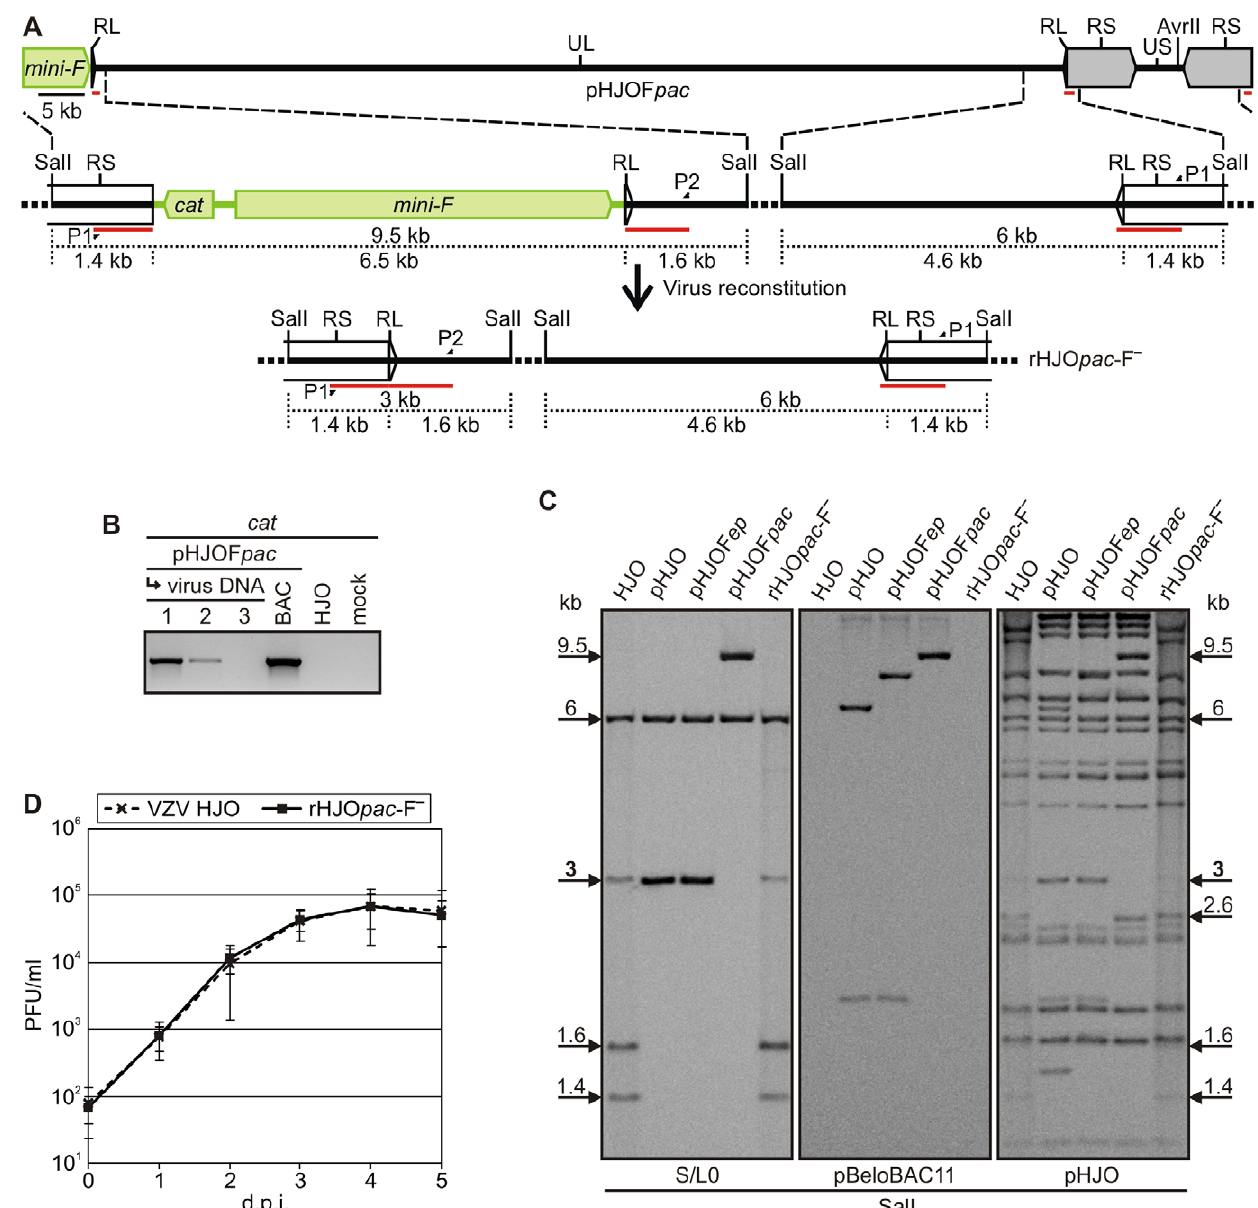
Figure 3. Mini-F sequence transposition into the genomic terminal junction and release upon virus reconstitution. A ) Detailed overview of the genomic transitions in pHJOF pac and rHJO pac -F - . The vector sequences (green) were released upon virus reconstitution from pHJOF pac and vector-free progeny rHJO pac -F - was generated. Lengths of both transitional SalI fragments and the distances from the SalI restriction sites to the genomic junctions are given (black dotted lines). Also, the binding sites of the Southern-blot probe (red bars) for analyzing the terminal junction and of the primers P1 and P2 (Table S1) used to generate the probe are indicated. B ) PCR analysis of the mini-F sequence release upon virus reconstitution. Total DNA from MeWo cells infected with pHJOF pac -derived progeny of virus passage 1–3 was analyzed with the cat -specific primers P3 and P4 (Table S1). BAC DNA of original pHJO as well as total DNA from MeWo cells infected with HJO wild-type or uninfected cells were analyzed as controls. C ) Southern-blot analysis of pHJOF pac and rHJO pac -F - in comparison to HJO, pHJO, pHJOF ep . BAC DNA was prepared from E. coli harboring pHJO, pHJOF ep , or pHJOF pac . Total DNA from MeWo cells infected with HJO or rHJO pac -F - was purified for examination of virus DNA. The isolated DNA was digested with SalI, separated electrophoretically on a 1% agarose gel, and blotted. Genomic junction-, vector-, or VZV sequences were detected with probes specific for viral sequences spanning the genomic transition at the ORF0 end of the UL region (termed S/L0, red bars in A), the pBeloBAC11 plasmid, or pHJO DNA, respectively. The 3 kb or 6 kb SalI fragments corresponding to the terminal or internal junction as well as the 9.5 kb SalI fragments that correspond to the terminal junction with mini-F vector in pHJOF pac as presented in A are marked. Also indicated are the 1.6 kb and 1.4 kb SalI fragments that correspond to termini of linear genomes within viral DNA as outlined in A as well as the 2.6 kb SalI fragments that correspond to the restored US unique AvrII site (arrows flanking the picture frame). D ) Growth kinetics of rHJO pac -F - and HJO. Multistep growth kinetics of rHJO pac -F - compared to wild-type virus HJO in MeWo cell cultures was performed. Means and standard deviations of two independent experiments with three separate results each are given.